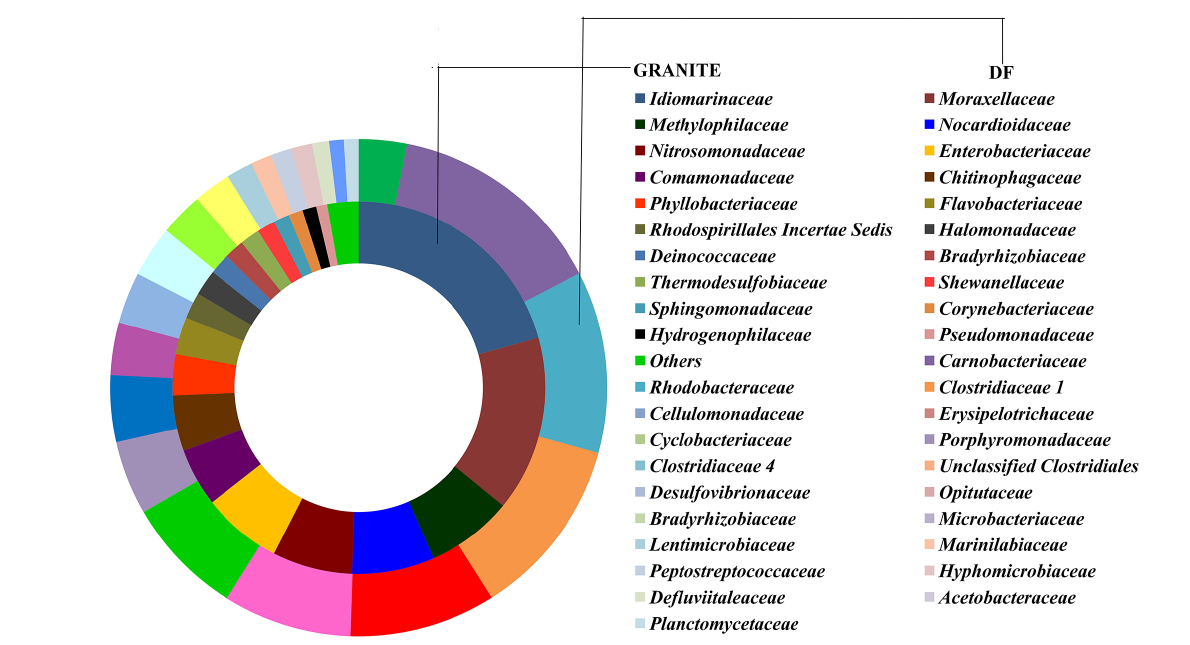
Figure 8. Microbial abundance comparison at family level of core OTUs of granitic rock cores (up to 1500mb.s.) (Dutta et al., 2018) and DF samples (DF; up to